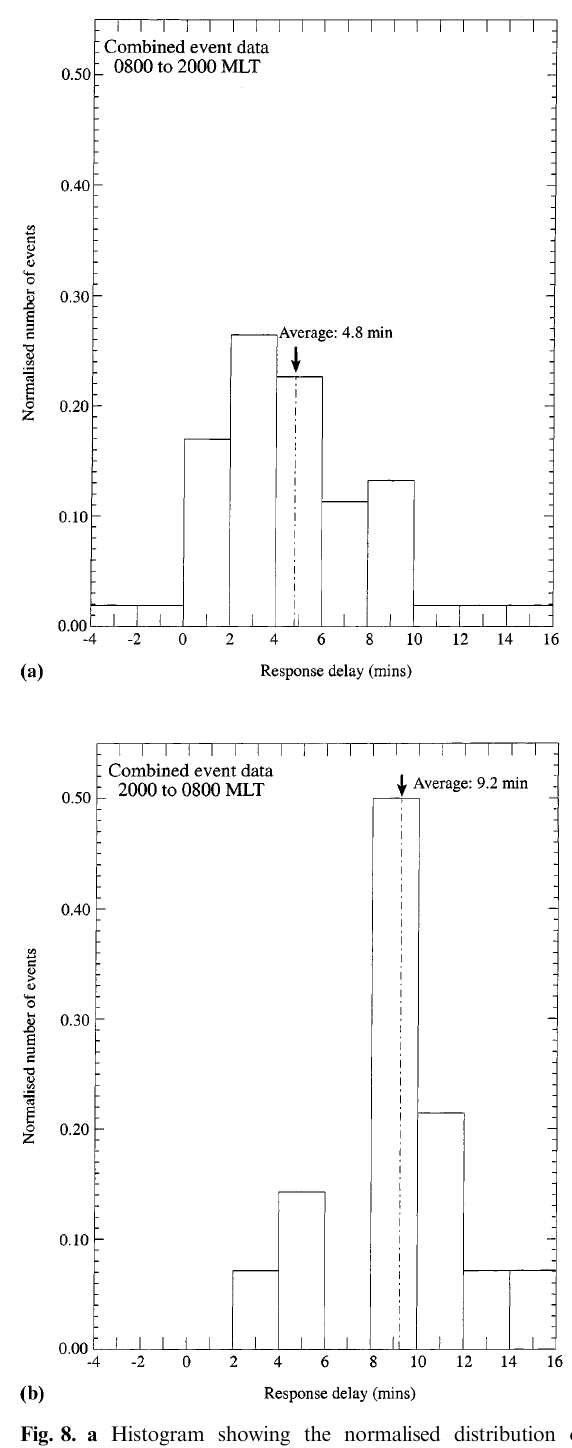
Fig. 8. a Histogram showing the normalised distribution of the number of events contributing to each 2-min bin of ionospheric flow delay time, for the 12-h local time sector centred on 1400 MLT. The average delay of all the dayside events is marked by the arrow and dot- dashed line . b As for a except for the 12-h local time sector centred on